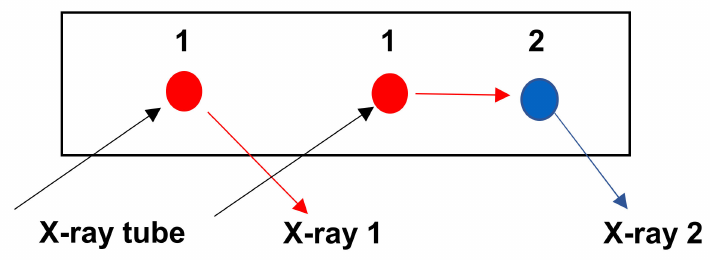
Figure 12. Fluorescence X-rays’ effects. The energy coming from atom 1 is strong and it is likely to excite the electrons of atom 2. Therefore, there is a secondary radiation from atom 2 to the detriment of the secondary fluorescence of atom